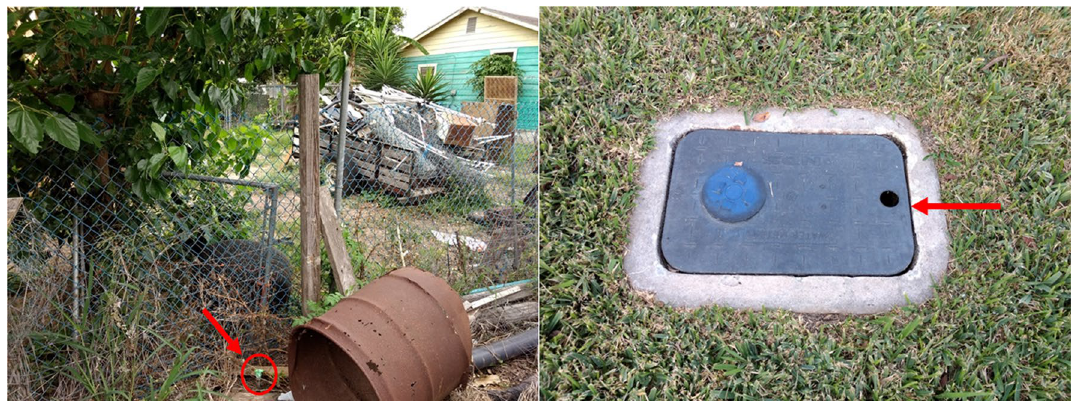
Figure 1. Logger placements: (left) in the open, (right) inside water meter.